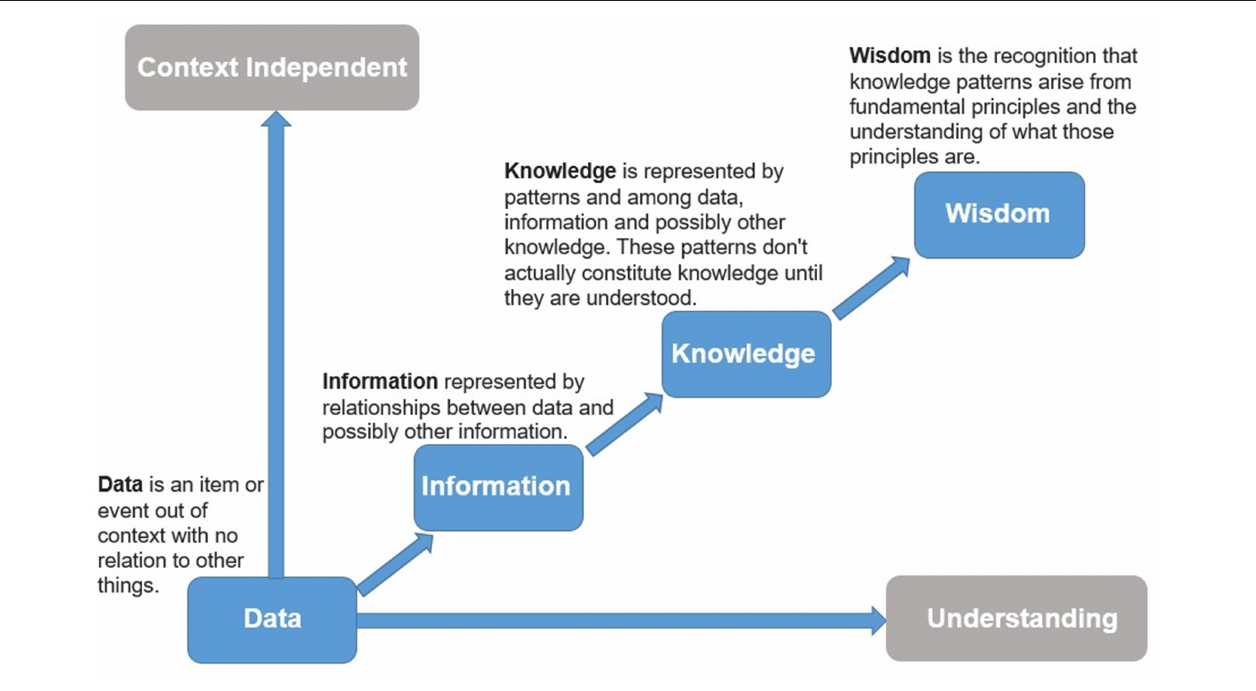
FIGURE 2 | The process of acquiring knowledge from data (Equity, 2018).